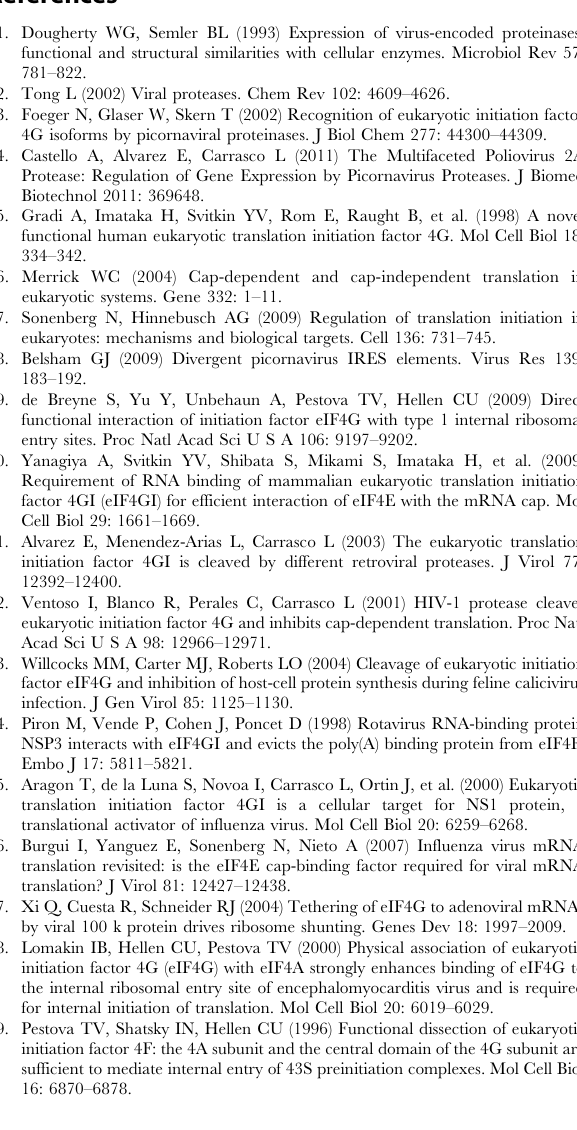
Figure S1 Kinetics of PV Replicon. BHKT7 cells were transfected withPV replicon. A) Protein synthesis was determined by labelling with [ 35 S]Met-Cys for 45 minutes every two hours from 1 to 7 hpt. B) Western blot analysis of the samples obtained in panel A using anti-eIF4G, anti-Luciferase and anti-phospho- eIF2 a . Figure S2 Rescue of picornavirus IRES translation by PV 2A pro in Huh7-T7 cells. A) Hepatoma cells were transfected with plasmids encoding EMCV IRES-luc, PV IRES-luc or HAV IRES-luc alone or co-transfected with pTM1-2A. At 2 hpt cells were treated or not with 200 m M Ars for 1 hour. Then, cells were harvested and lysated in luciferase buffer and luc activity was measured and represented as percentage from at least three